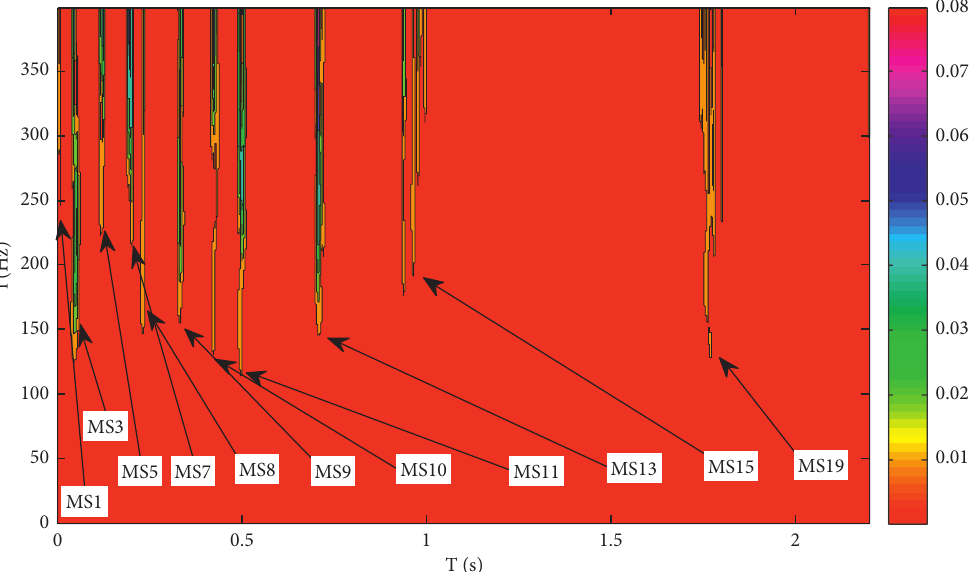
Figure 3: Time-frequency distribution of each detonator after S